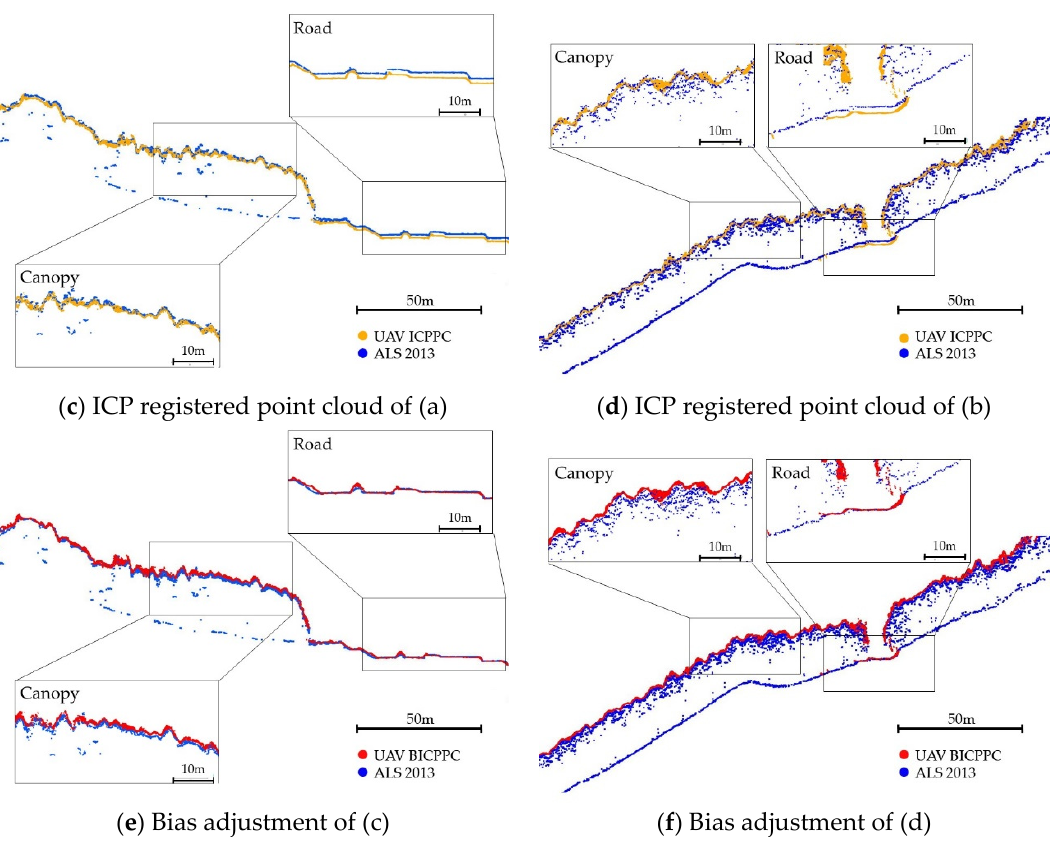
Figure 4. An illustration of point cloud registration of the Hinoki forest at the Kameyama site (left column) and the Owase site (right column). ( a , b ) show a significant altitude difference between the UAV-SfM RPC (the yellow points) and the ALS point cloud in 2013 (the blue points). The altitude of RPC is overestimated in ( a ) but underestimated in ( b ). A horizontal shifting in ( a ) is also evident. ( c , d ) display the approximation of the UAV-SfM ICPPC (the orange points) and the ALS point cloud. The acquisition year of the ALS data is 5 and 6 years earlier than the UAV data for the Kameyama and Owase forests, respectively. Orange points must be over-adjusted. The bias can be determined as the altitudinal difference of a ground surface of the ICPPC and the ALS data because the ground surface is normally with a fixed altitude. ( e , f ) demonstrate that the UAV-SfM BICPPC data (the red points) is in line with the ALS point cloud. The adjustment scalar was 1.2009 m for the Kameyama forest and 1.3035 m for the Owase site, determined as the average altitude of identifiable ground surface points surrounding the